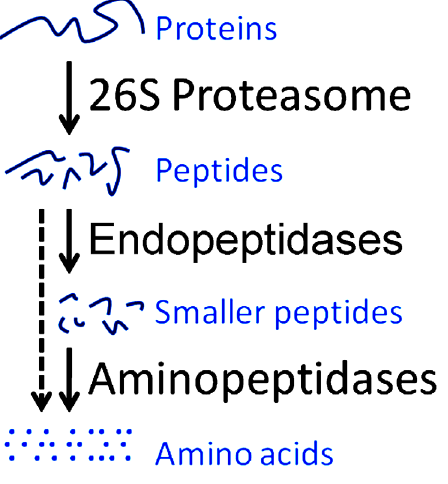
Figure 1. Cytoplasmic protein turnover. The 26S proteasome, a multicatalytic complex cleaves proteins into peptides typically 3–25 residues long, which are further degraded into amino acids by a variety of downstream endopeptidases and/or aminopeptidases.